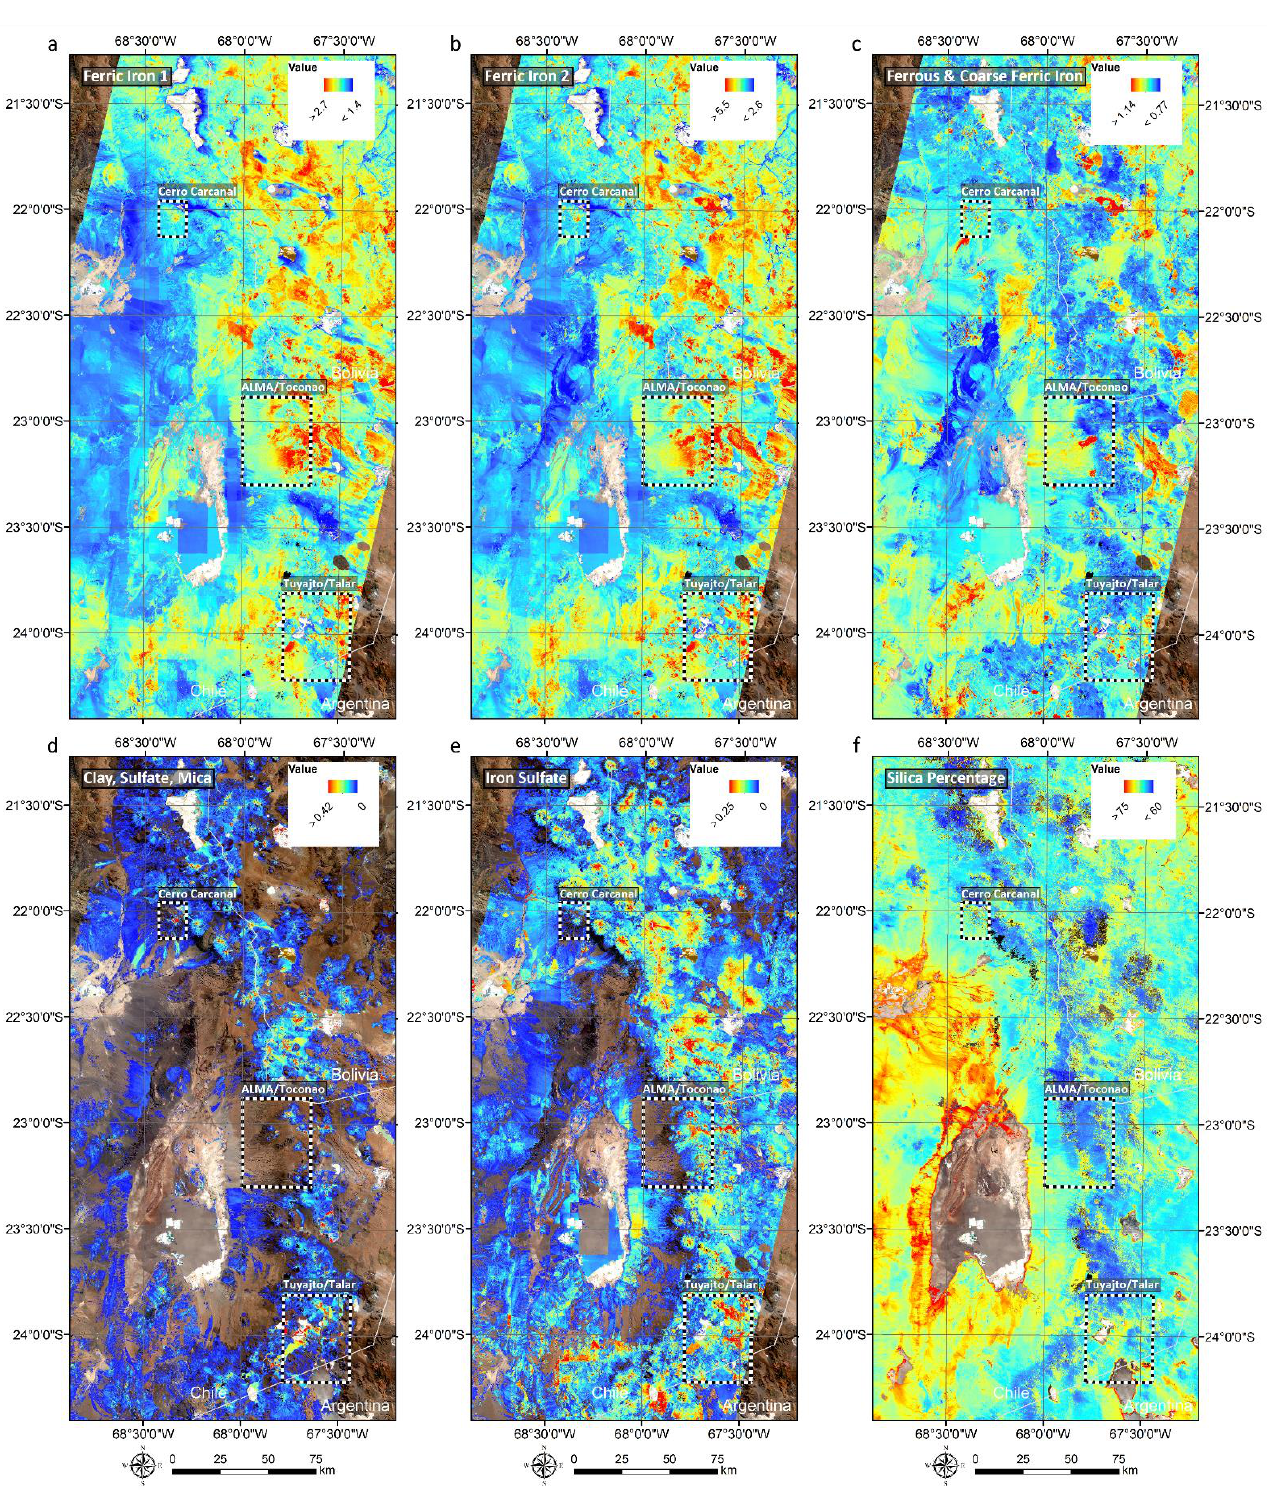
Figure 2. ( a ) Landsat index 1 “ferric iron 1 redness”. ( b ) Landsat index 2 “ferric iron 2”. ( c ) Landsat index 3 “ferrous and coarse ferric iron”. ( d ) Landsat index 4 “clay, sulfate, and mica”. ( e ) Landsat